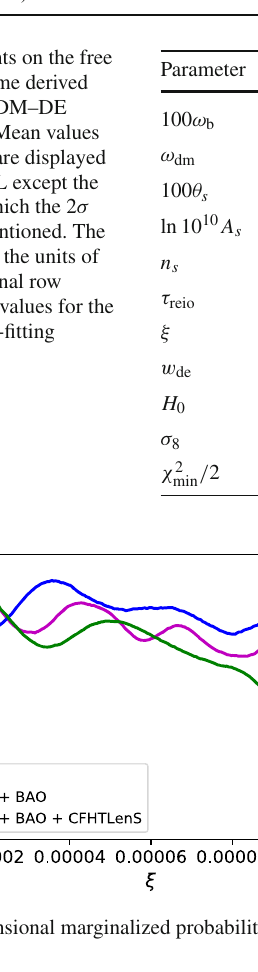
= δ p /δρ = 1 ( c 2 c 2 is in units of the speed of light). de de s s This necessarily implies that DE is a very light scalar field, as a typical canonical scalar field model with mass (cid:2) H 0